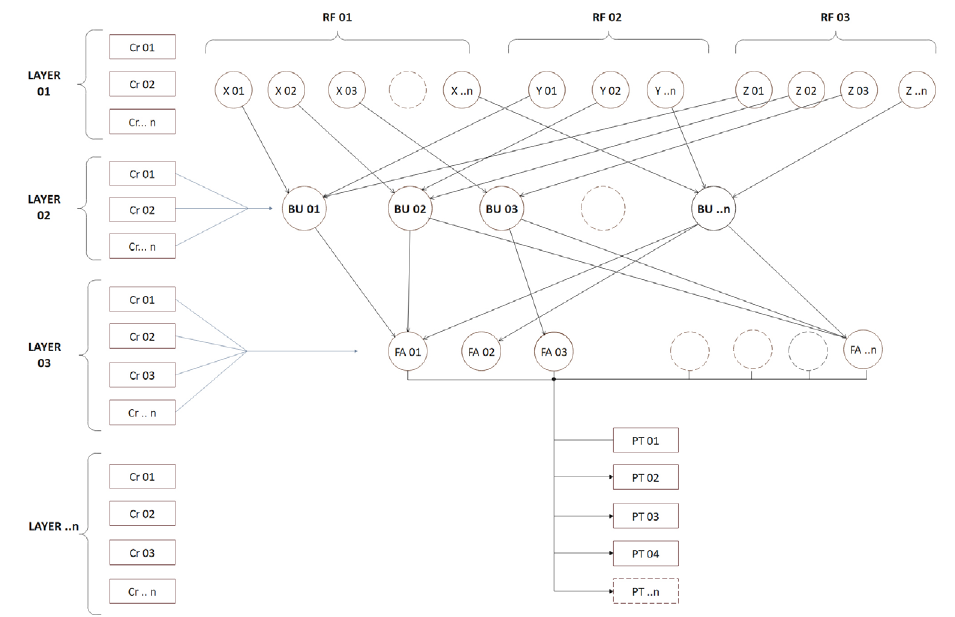
Figure 11. A systematic survey model shows different layers to find cases (source: authors)